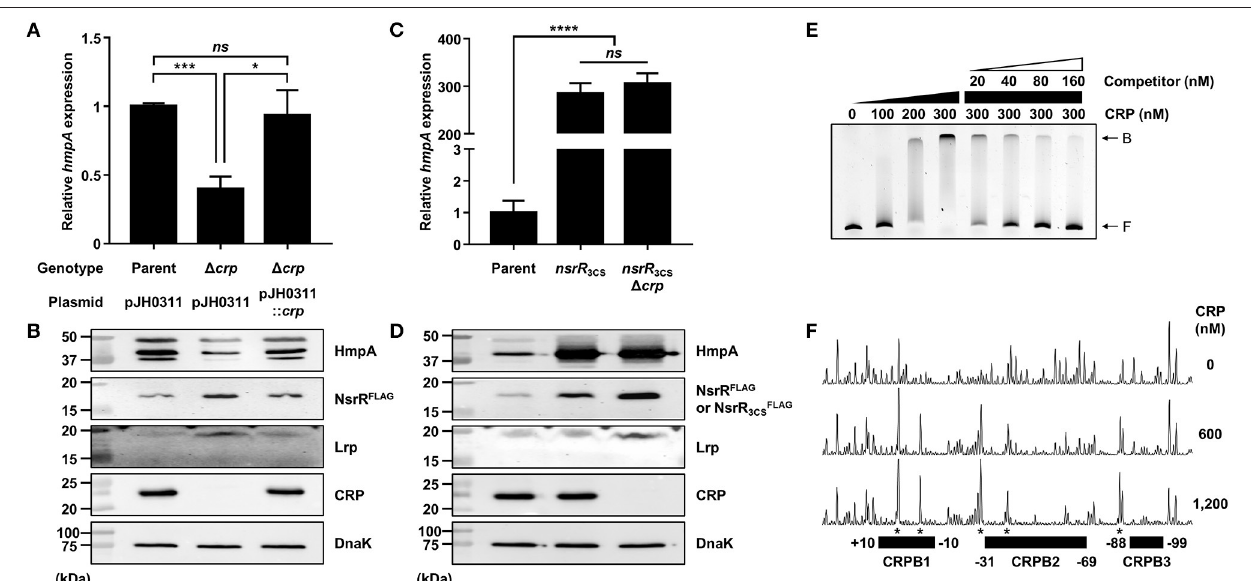
FIGURE 7 | The effect of the crp mutation on hmpA and nsrR transcription, and the specific binding of CRP to the nsrR - hmpA regulatory region. (A–D) Total RNA and proteins were isolated from the parent and mutant strains grown aerobically to an A 600 of 0.5. (A,C) The hmpA transcript levels were determined by qRT-PCR, and the hmpA transcript levels in the parent strain were set to 1. Error bars represent the SD. Statistical significance was determined by the Student’s t- test (* p < 0.05; *** p < 0.0005; **** p < 0.00005; ns , not significant). (B,D) The cellular HmpA, NsrR FLAG or NsrR FLAG 3CS , Lrp, CRP, and DnaK (internal control) protein levels were determined by Western blot analysis. Molecular size markers (Bio-Rad) are shown in kDa. Parent, parent strain; 1 crp , crp -deletion mutant; pJH0311, broad-host-range vector; pJH0311:: crp , pJH0311 carrying the crp gene (pKK1502); nsrR 3CS , strain expressing apo-locked NsrR FLAG ; nsrR 3CS 1 crp , crp -deletion mutant expressing apo-locked NsrR FLAG . (E) A 393-bp DNA fragment of the nsrR - hmpA regulatory region (10nM) was labeled with 6-FAM, and then incubated with increasing amounts of CRP as indicated. For the competition analysis, various amounts of the unlabeled DNA fragment were added as a self-competitor. B, bound DNA; F, free DNA. (F) The same DNA probe (40nM) was incubated with increasing amounts of CRP as indicated, and then digested with DNase I. The regions protected by CRP are indicated by block boxes (CRPB1, CRPB2, and CRPB3). The nucleotides showing enhanced cleavage are indicated by asterisks. Nucleotide numbers shown are relative to the TSS of nsrR